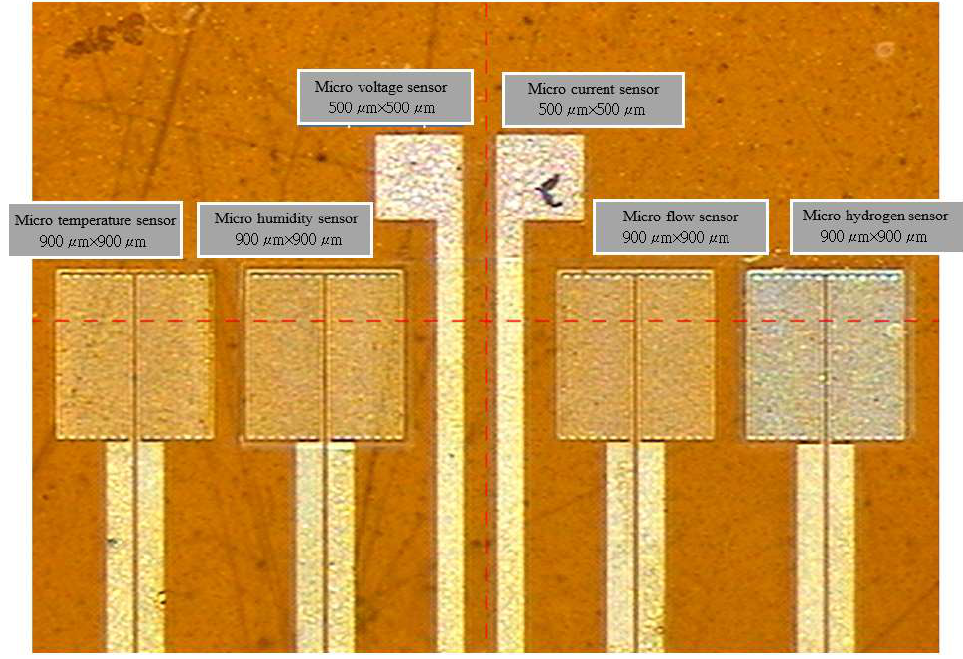
Figure 3. Optical microscope diagram of flexible six-in-one microsensor.